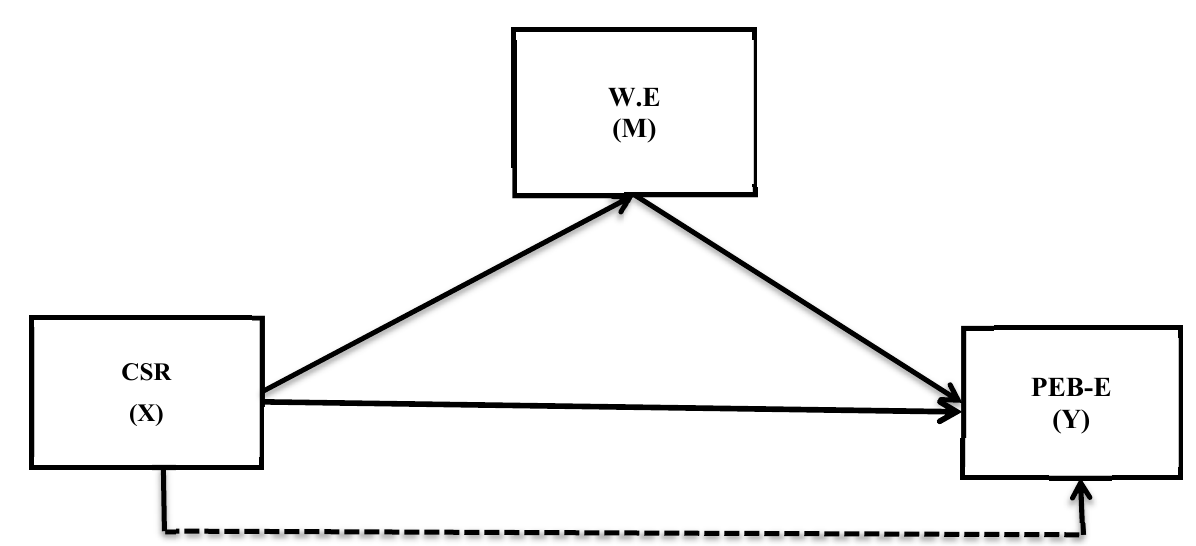
Figure 1. The proposed research model: Corporate social responsibility (CSR) = the independent variable (X), work engagement (W.E) = the mediating variable (M), and pro-environmental behavior of employees (PEB-E) = the dependent variable (Y).